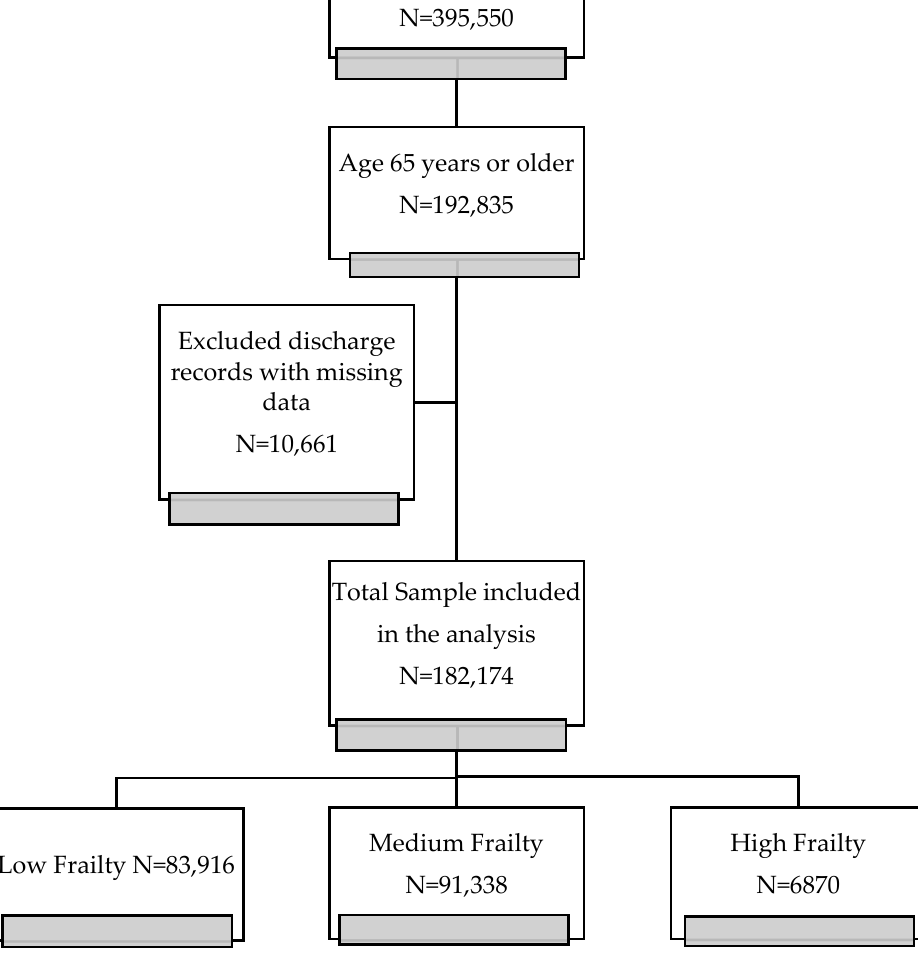
Figure 1. Study Flowchart.